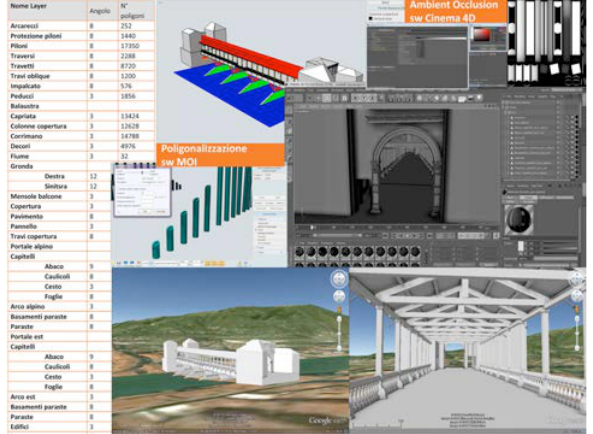
Figure 8. The Bassano bridge 3D semantic model construction: from acquired data to with AO visualization in